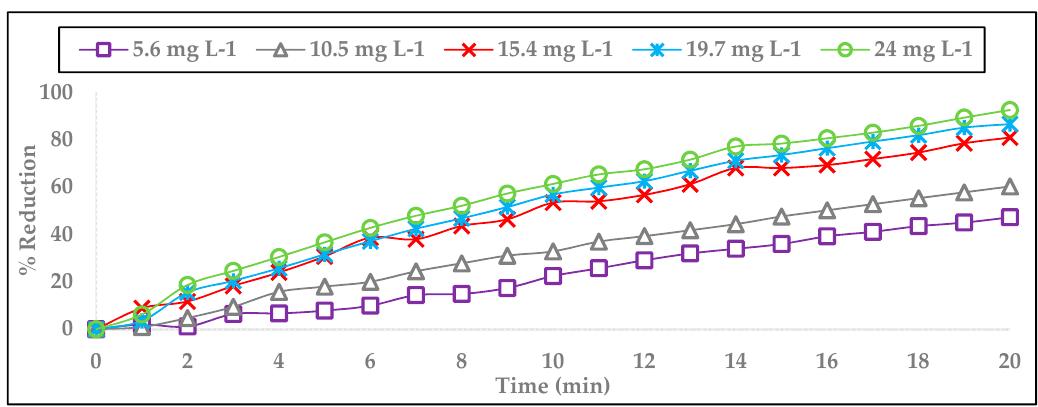
Figure 7. Evolution of simazine reduction over time at different doses of O 3 . Experimental conditions: [Simazine 0 ] = 0.7 mg L − 1 ; [O 3 ] = 5.6, 10.5, 15.4, 19.7 and 24 mg L − 1 ; pH 0 6.7, pH (20 min) 4.5–4.9; T = 25 °C.